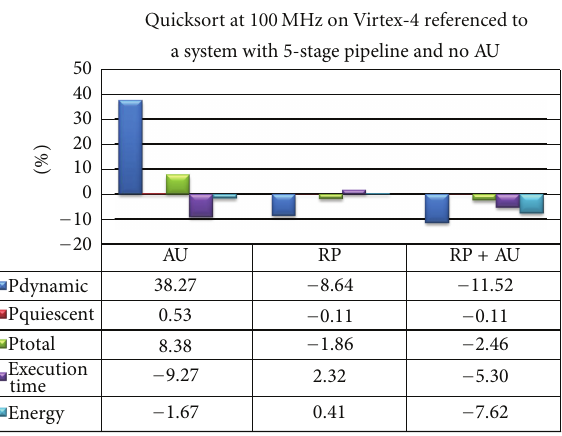
Figure 23: Impact of the MicroBlaze configurations for the Quicksort algorithm.